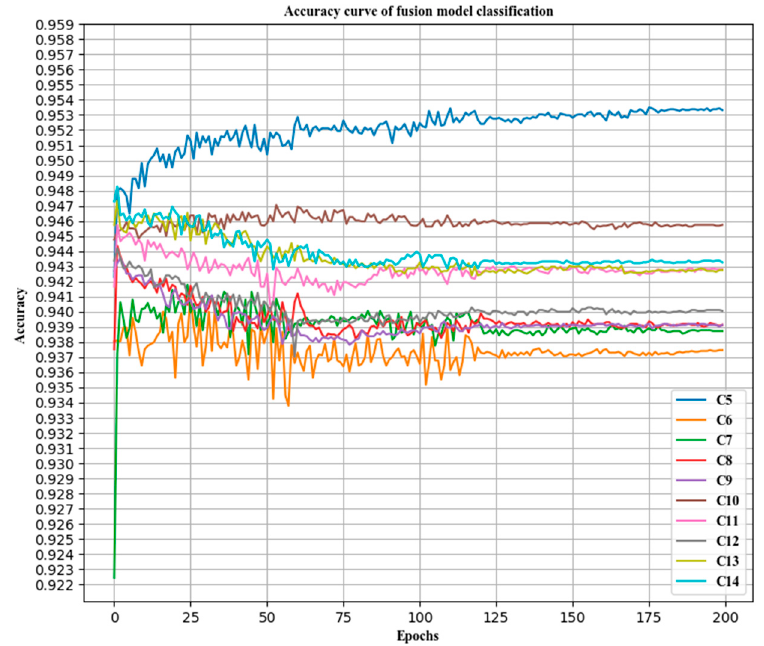
Figure 9. The classification accuracy curve of some individual models.